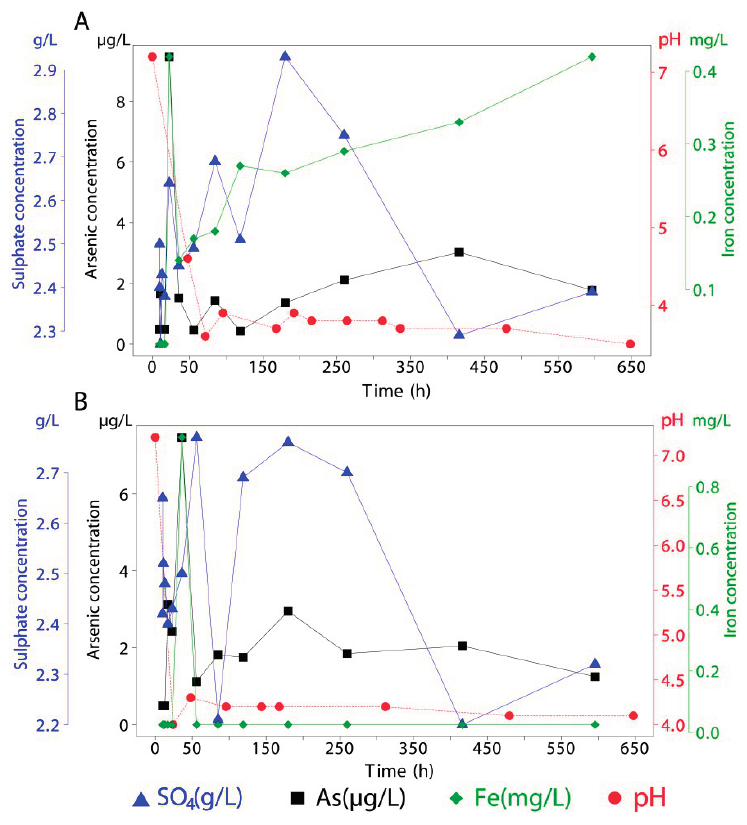
Figure 5. Arsenic release test for schwertmannite. ( A ) Arsenic release from co-precipitated schwertmannite and ( B ) arsenic release from adsorbed